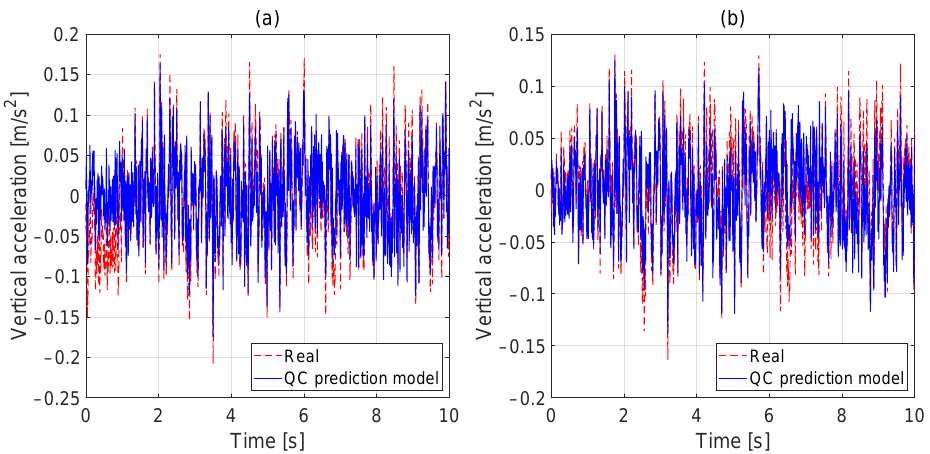
Figure 5. Unsprung mass acceleration; ( a ) tire inflation pressure 230 kPa; and ( b ) tire inflation pressure 130 kPa. Vehicle speed 60 km/h, road class B.